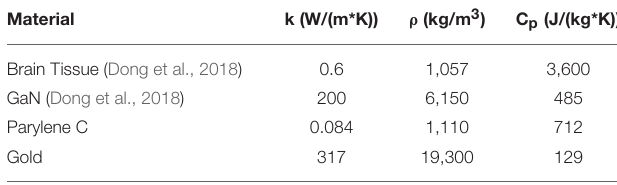
TABLE 1 | Material properties for thermal